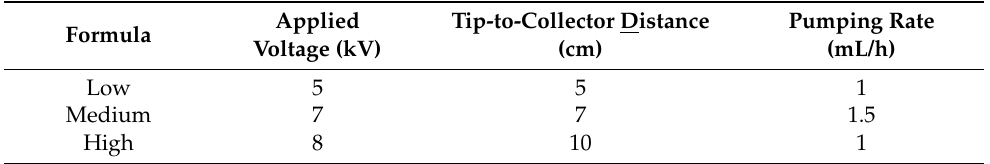
Table 2. Parameters for electrospinning apparatus.